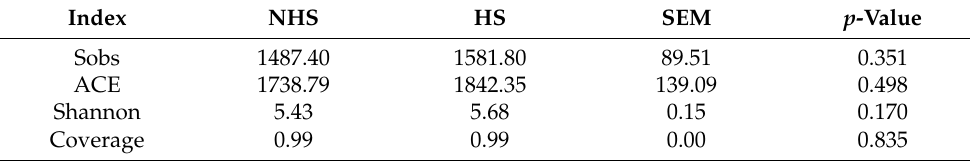
Table 3. Effects of HS on richness and diversity of rumen bacteria in buffalo ( n = 6).